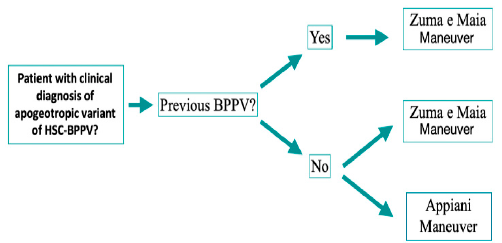
Figure 5. Treatment algorithm.